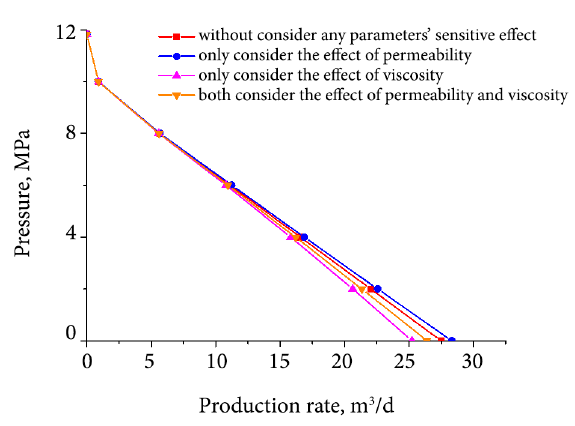
Figure 10. Comparison of the calculated production for different water saturation conditions